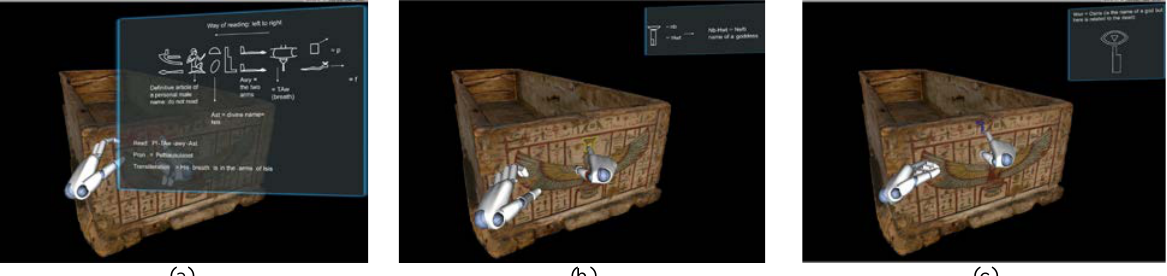
Figure 9. Some pictures of the implemented VR scenario: (a) the highlighting and translation of the name of the deceased (b) ) the highlighting and translation of the name of the Goddess Nefti (c) the highlighting and translation of the name of the God Osiris, related to the